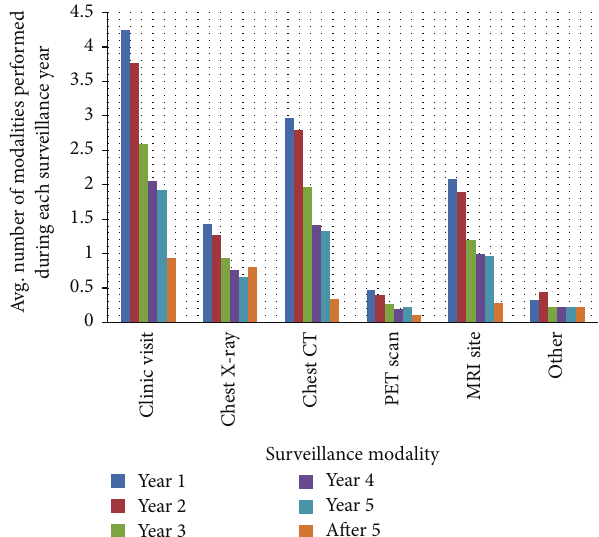
Figure 3: Surveillance protocols. Average surveillance strategies based on 38 respondents depicted as the average number of all mo- dalities performed during each year of surveillance. Chest CT was more common for surveillance as compared to chest X-ray by an approximate 2: 1 ratio in years 1–3, with reversal in strategy after year 5 with X-ray becoming more common by an 8 :3